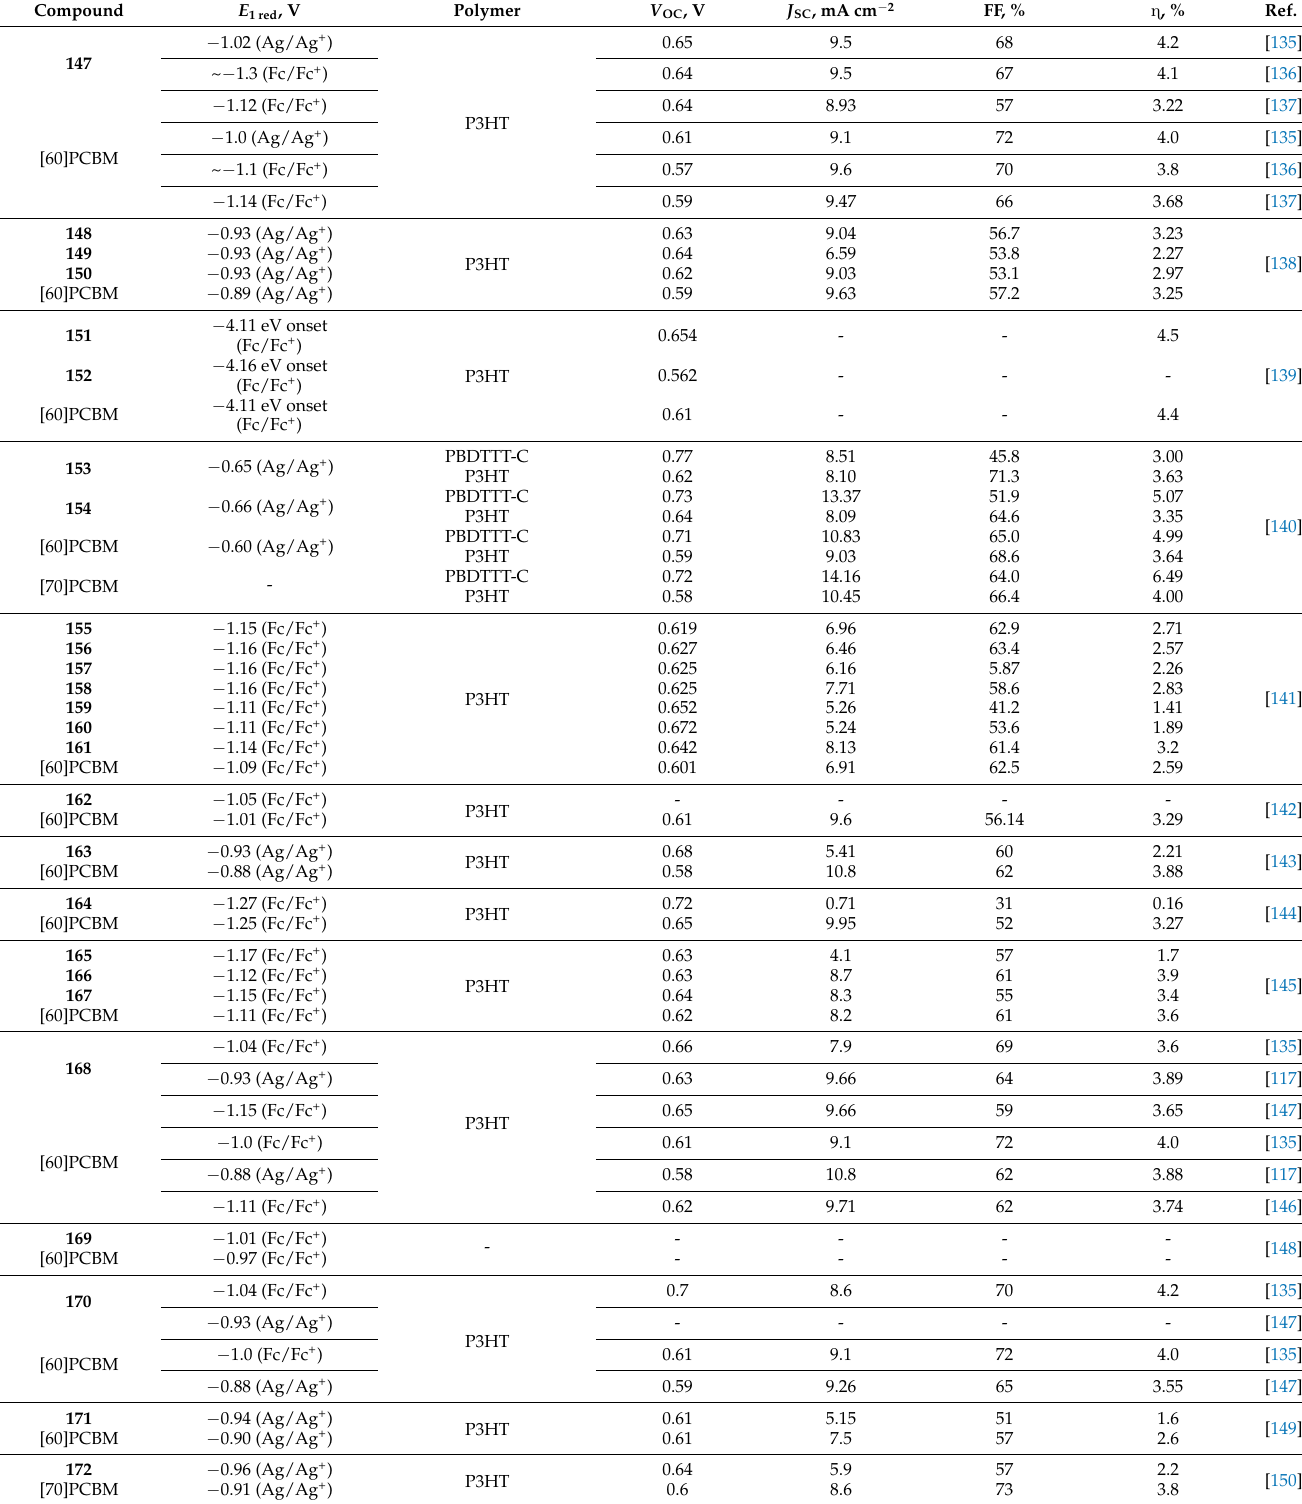
Table 4. First reduction potentials and characteristics of the solar cells based on the cyclohexene fullerene